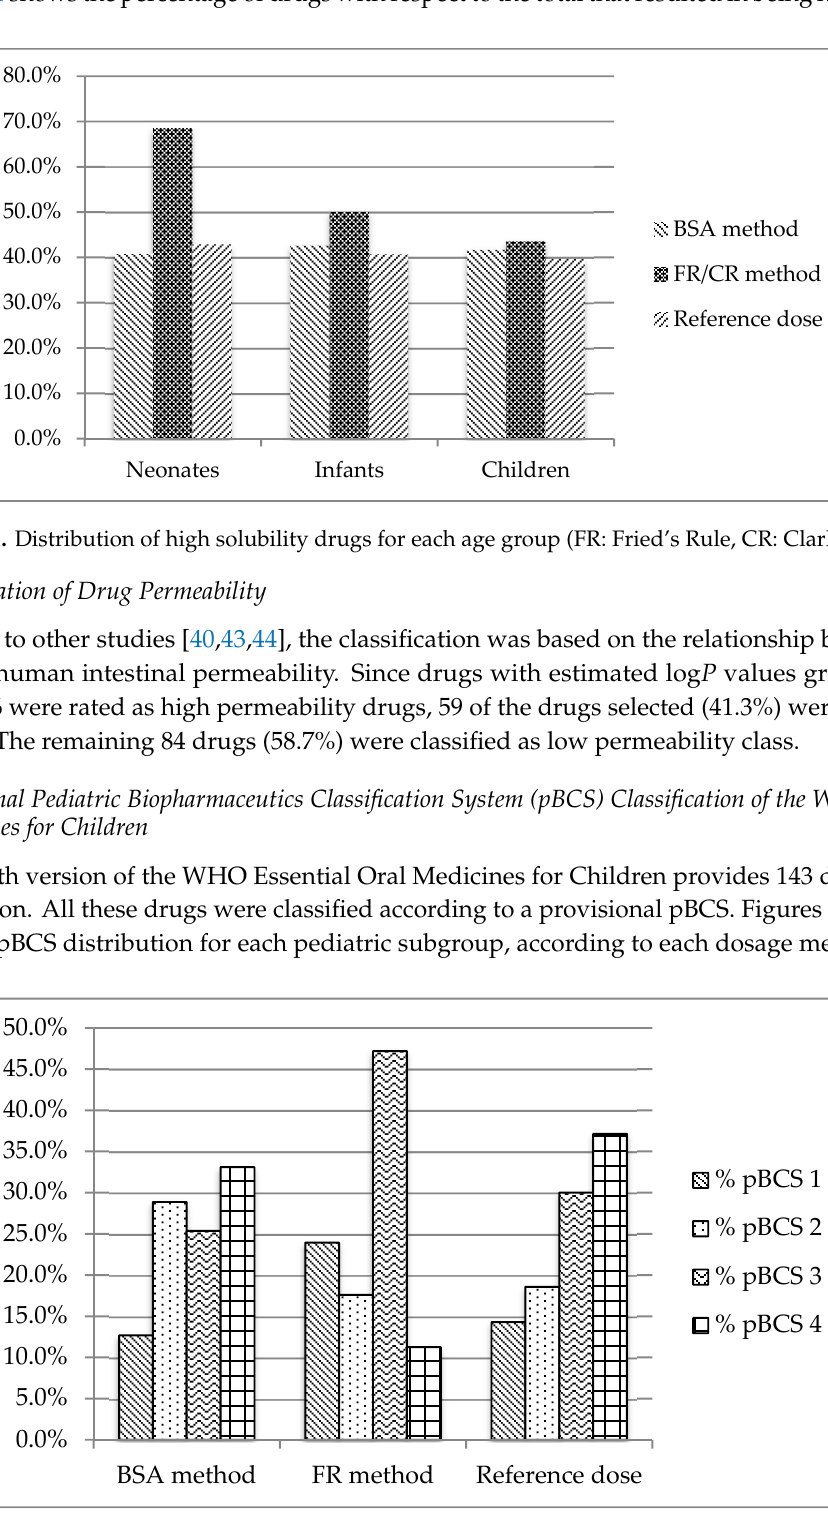
Figure 2. Distribution of provisional pBCS classification in neonates (0–1 month).